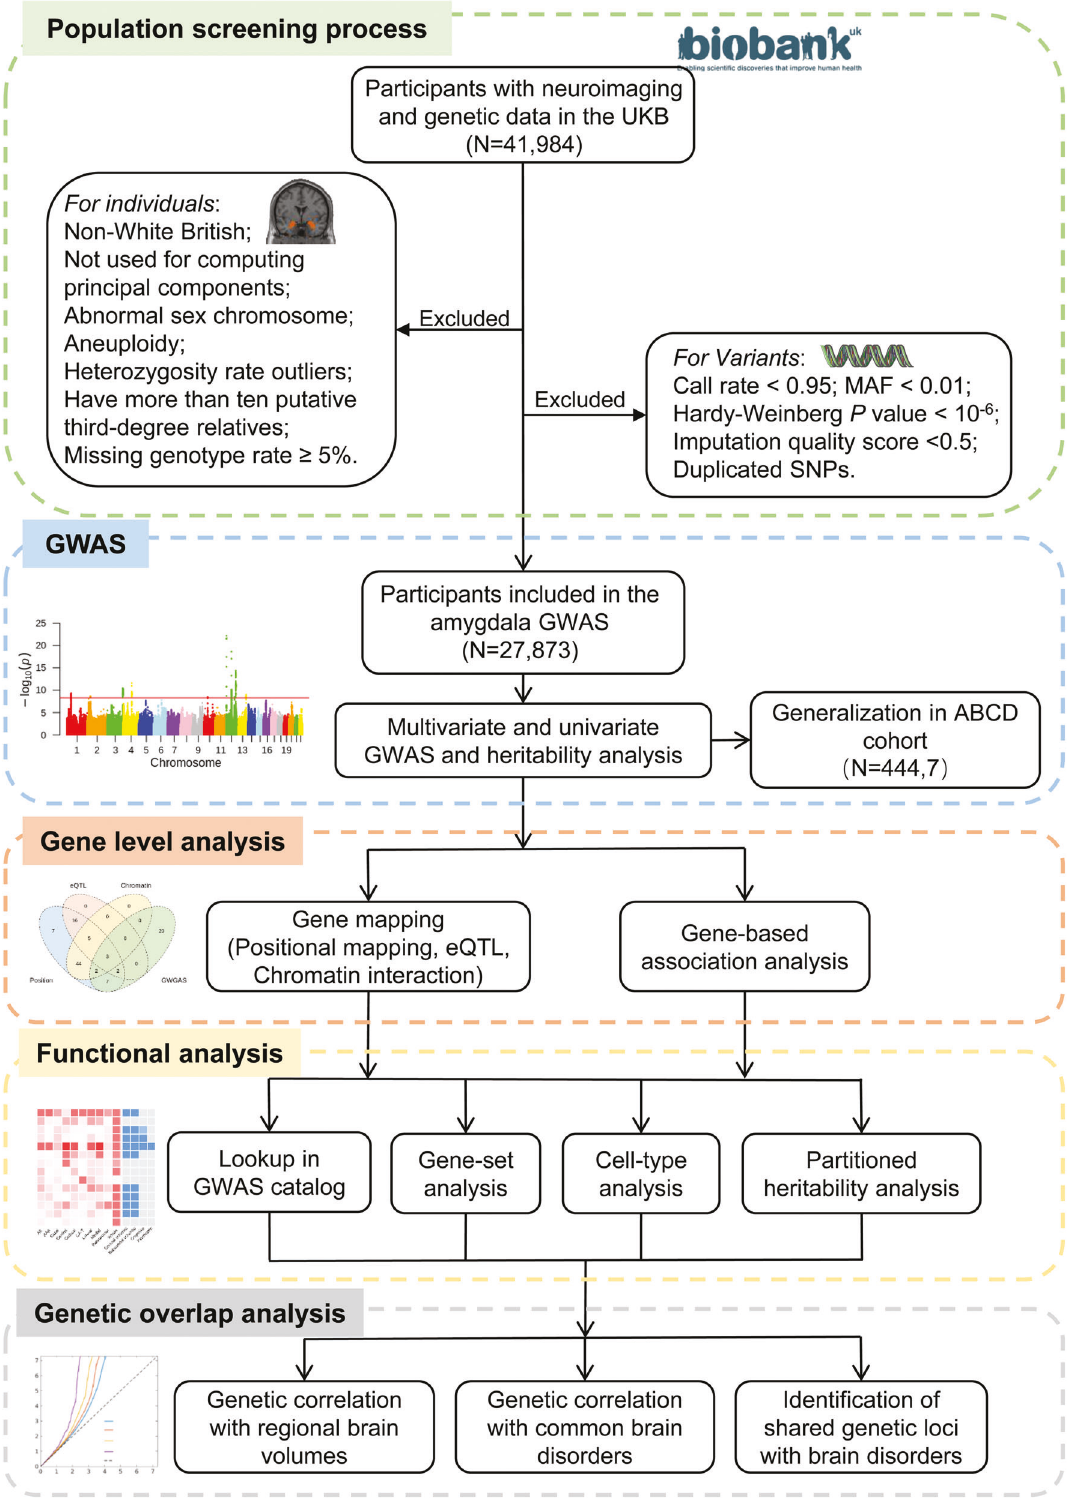
Fig. 1 The schematic work fl ow of the study design. UKB UK biobank, MAF minor allele frequency, SNP single nucleotide polymorphism, GWAS genome-wide association study, ABCD Adolescent Brain Cognitive Development, eQTL expression quantitative trait